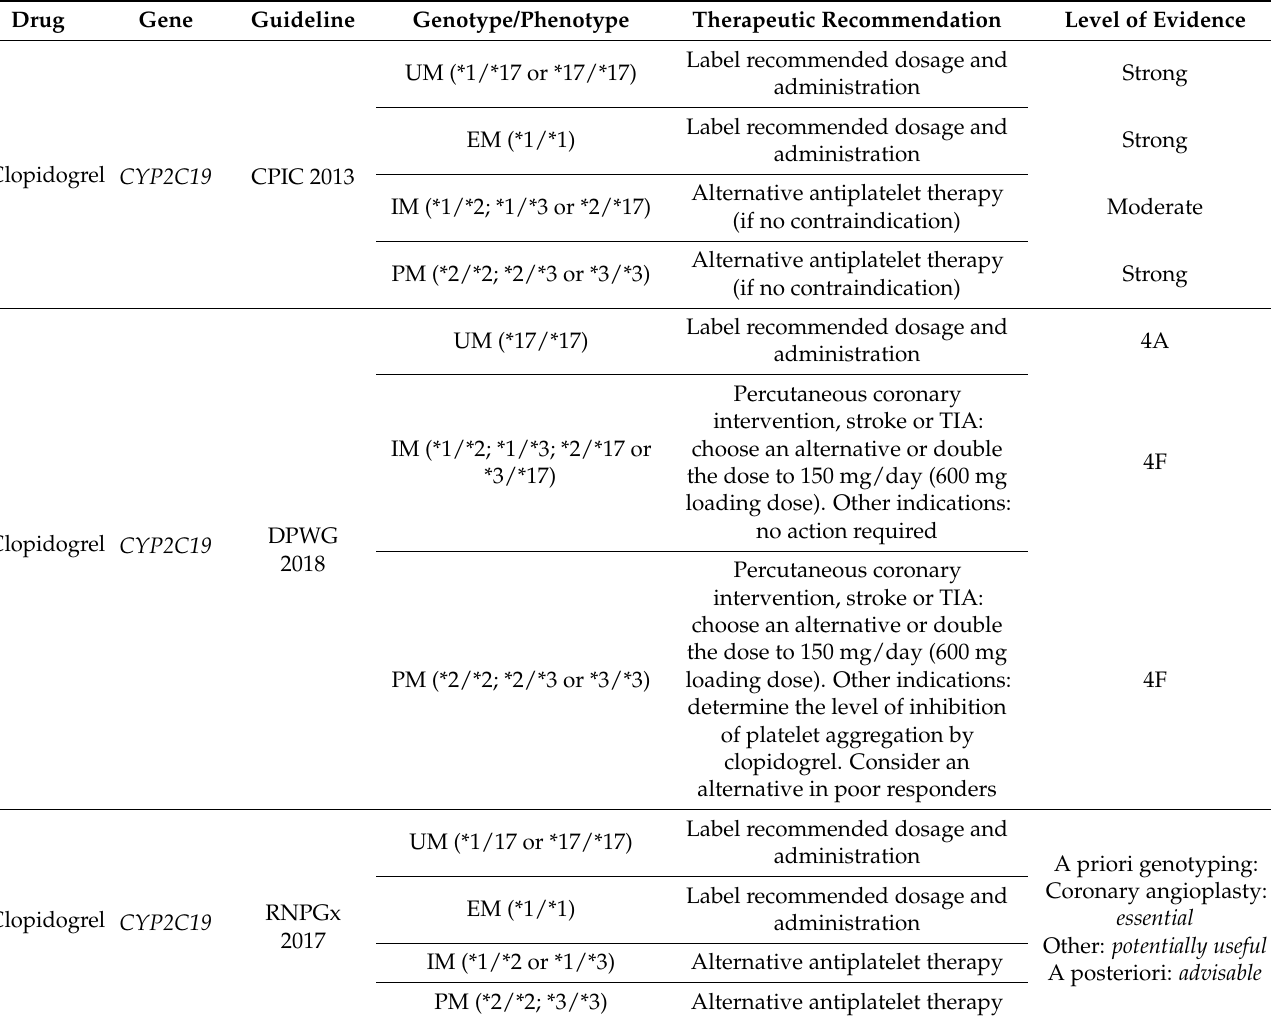
Table 3. Drug-gene pairs and dose recommendations by different clinical guidelines.